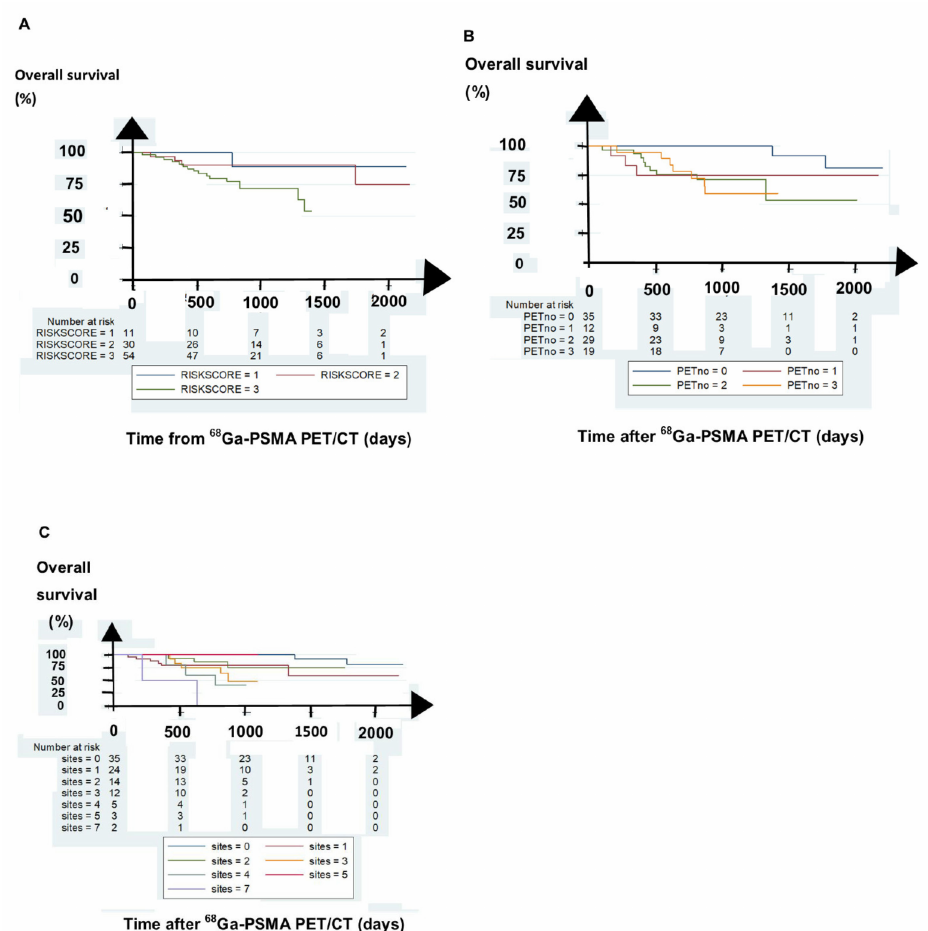
Figure 2. Overall survival after the 68Ga-PSMA PET/CT scan. ( A ) Shows that the risk score of the patients predicted overall survival. ( B ) Shows that the most advanced regional locations of positive sites on 68Ga-PSMA PET/CT predicted overall survival. PETno 0 denotes negative findings on 68Ga-PSMA PET/CT scans, PETno 1 denotes positive sites in the prostate bed, PETno 2 denotes positive sites in regional lymph nodes, and PETno 3 denotes positive findings in distant organs. ( C ) Shows that the number of positive sites on the 68Ga-PSMA PET/CT scan predicted overall